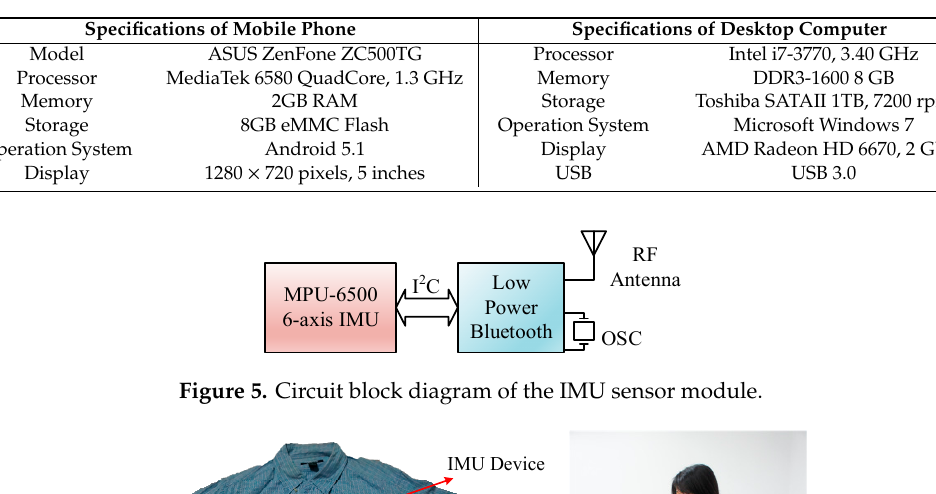
Table 1. Specifications of the mobile phone and the desktop computer.